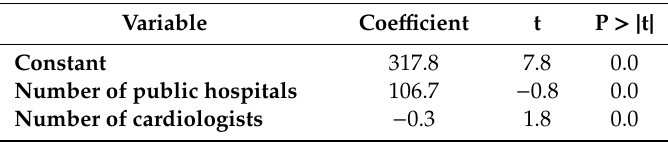
Table 2. The impact of di ff erent factors on the deaths caused by CVDs in Romanian macro-regions